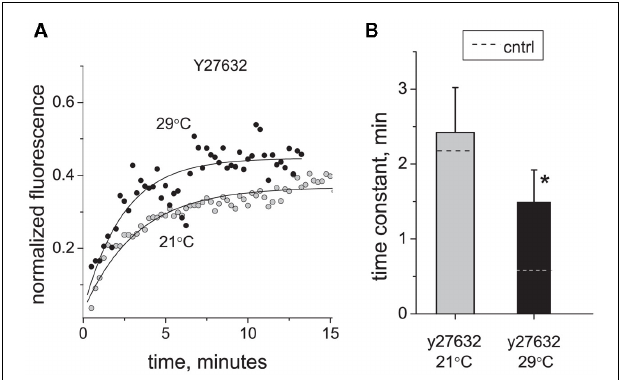
FIGURE 5 | Effect of RhoA kinase inhibition on P2X3 receptor turnover and its temperature sensitivity. (A) Typical examples of P2X3 receptor recovery traces at 21˚C (tau = 2.4min) and 29˚C (tau = 2.1min) in the presence ofY27632. (B) Effect of RhoA kinase inhibitorY27632 (2 μ M) on the time constant of P2X3 receptors recovery after photobleaching. For comparison, control levels in B are shown with dotted lines.The asterisk indicates a significant difference from control values at P < 0.05.